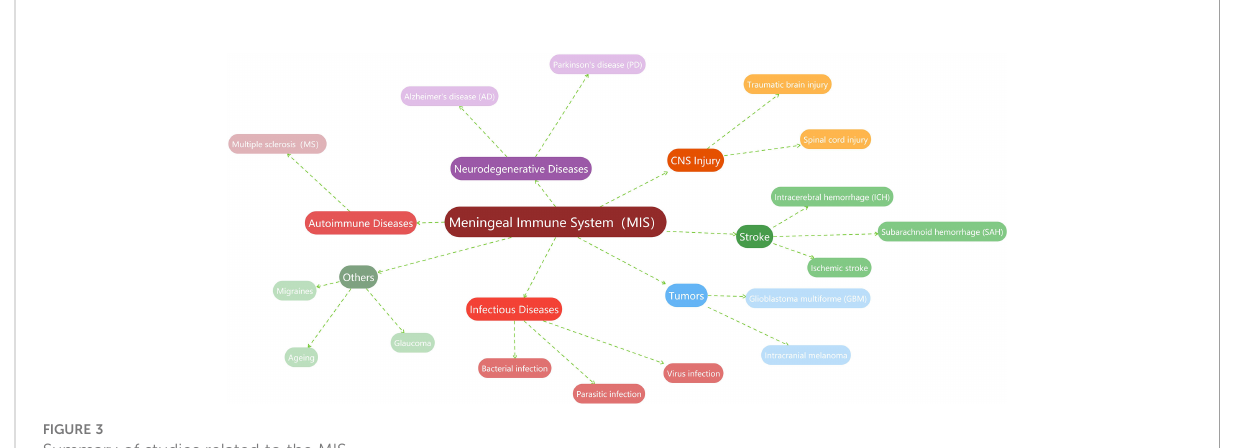
FIGURE 3 Summary of studies related to the